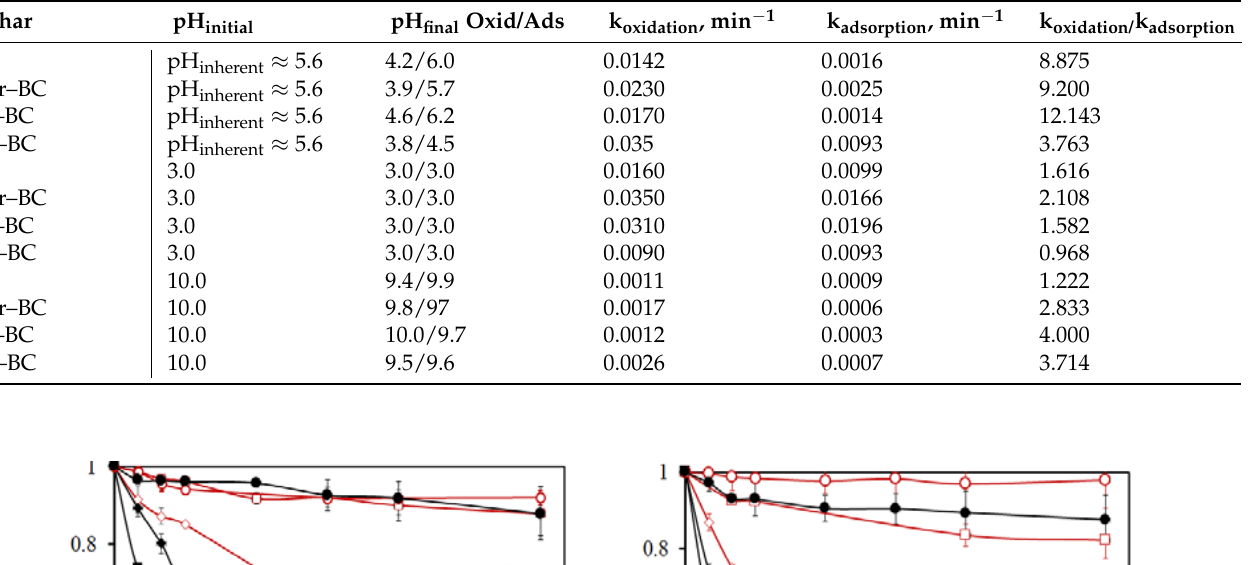
Table 2. k app values for 250 µ g/L LOS adsorption and degradation for the studied biochars at initial pH 3, 5.6, and 10. Experimental conditions (biochar) = 90 mg/L and (SPS) = 250 mg/L in UPW.